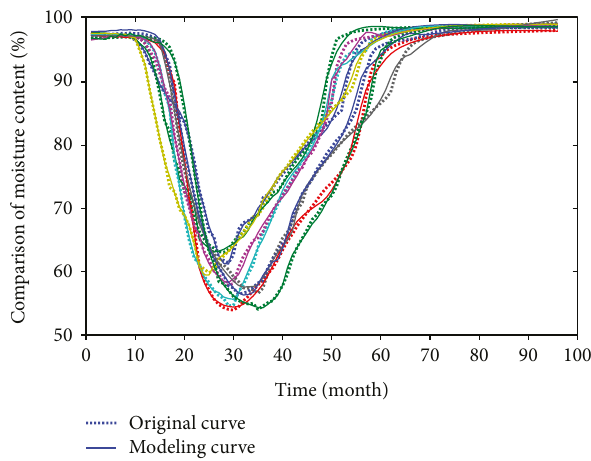
Figure 10: Comparison for the moisture content of nine production wells.